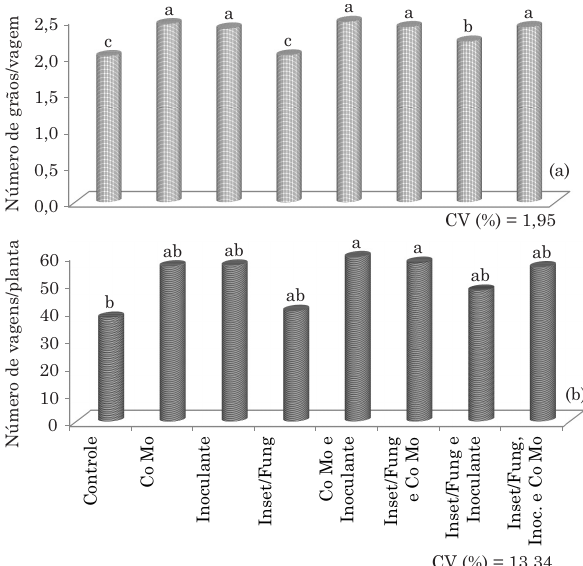
Figura 5. Número de grãos por vagem (a) e número de vagens por planta (b), em função de diferentes tratamentos de sementes. Safra 2010/ 11. Médias seguidas de mesma letra não diferem pelo teste de Tukey (p<0,05).